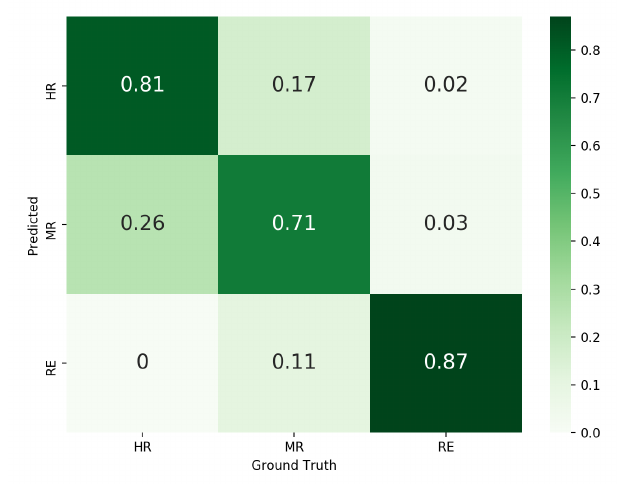
Figure 10. Confusion matrix of the four classes for 25 days ahead risk prediction for 180